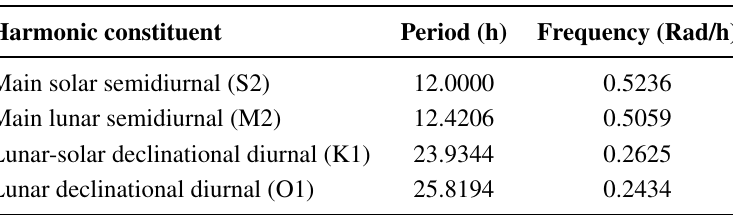
Table 1. Periods and frequencies of the harmonic